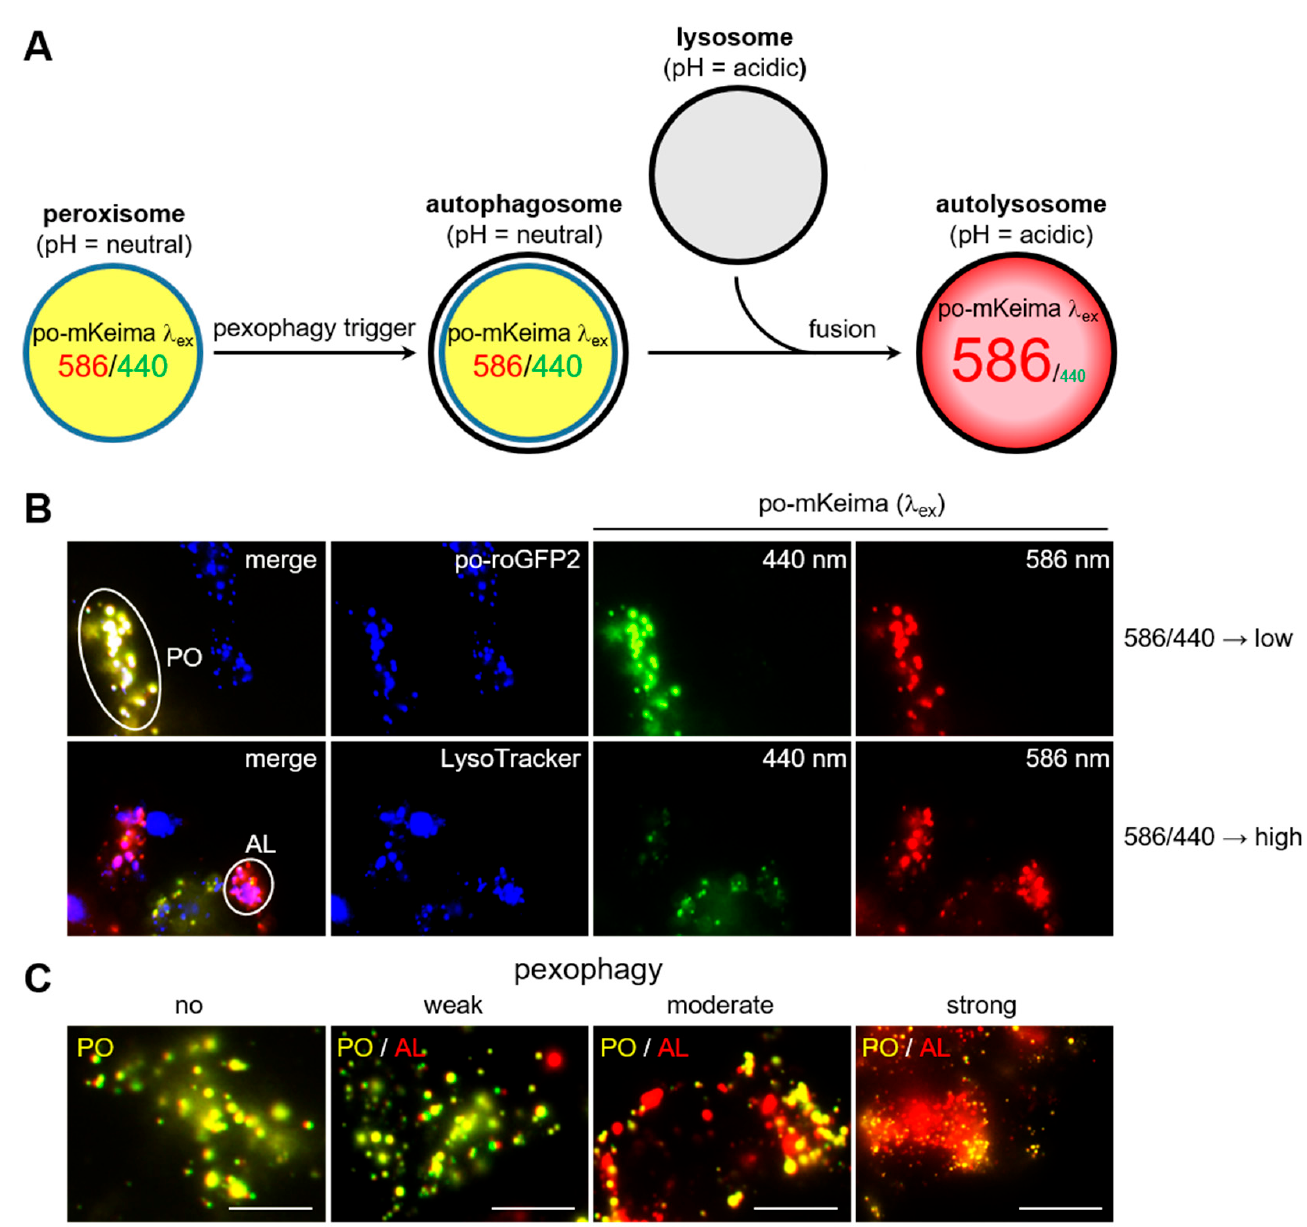
Figure 1. Pexophagy detection in living cells using po-mKeima. ( A ) Schematic outline. ( B ) Colocal- ization analysis between the peroxisomal marker po-roGFP2 (false color: blue) or the acidotropic fluorescent probe LysoTracker (false color: blue) and po-mKeima excited at 440 nm (false color: green) or 586 nm (false color: red). The yellowish (=low 586/440 excitation peak ratio) and reddish (=high 586/440 excitation peak ratio) dots represent peroxisomes (PO) and autolysosomes (AL), respectively. ( C ) Examples of DD-DAO/po-mKeima Flp-In T-REx 293 cells displaying no, weak, moderate, or excessively high levels of pexophagy. Scale bar, 10 µm.